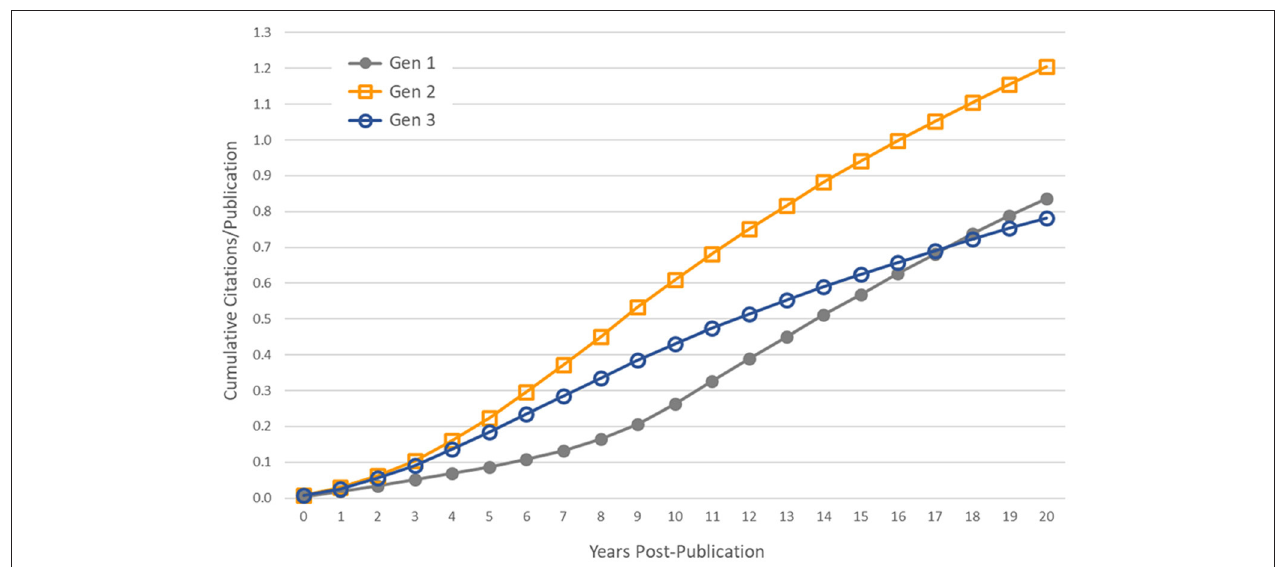
Frontiers in Research Metrics and Analytics |